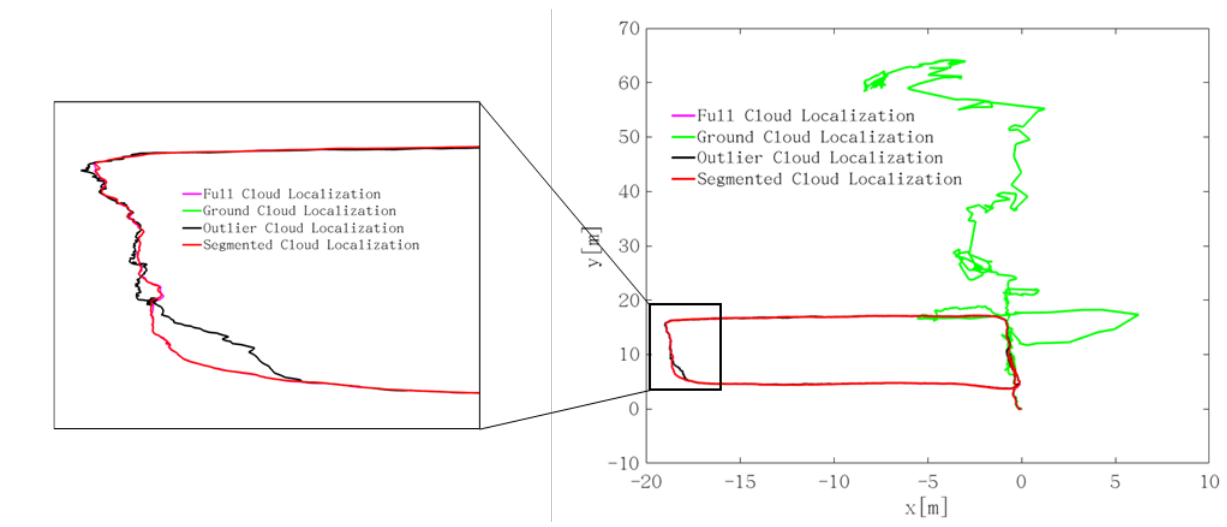
Figure 21. Comparison of the point cloud segmentation on